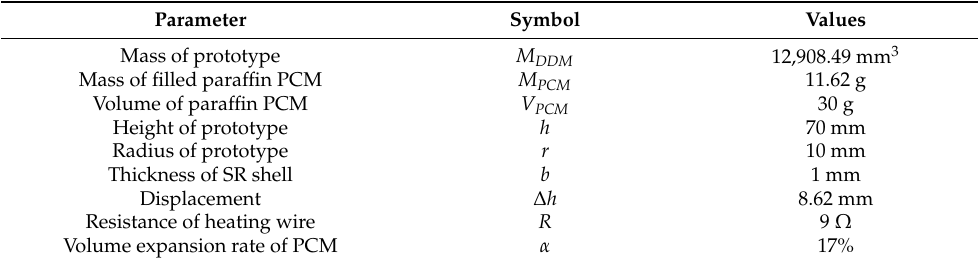
Figure 1. Electrothermal deep-sea drive microunit: ( a ) Overall schematic, where h is the height of prototype shown in Table 1, ( b ) schematic cross-section showing the main internal structure, where r is the radius of prototype and b is the thickness of SR shell shown in Table 1, ( c ) exploded view showing the various components and combinations of the microunit, i.e., (1) electrode, (2) high temperature-resistant O-ring, (3) end cover, (4) heating wire, (5) paraffin PCM, (6) SR shell, (7) restricted layer. ( d ) Working principle diagram of the microunit, where ∆ h is the displacement shown in Table 1. Considering the laboratory manufacturing level and its own experience, the design parameters of the deep-sea drive microunit are shown in Table 1. Table 1. Parameters of the electrothermal deep-sea drive microunit.